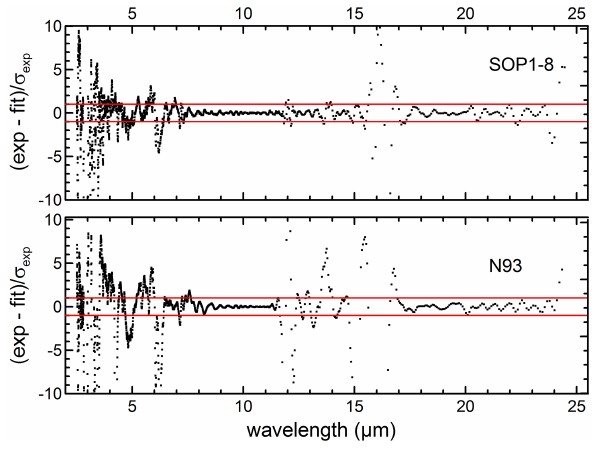
− fit ) ) of the fit normalized by the Figure 5. Residuals ( R = ( exp σ exp measurement errors calculated for SOP1–8 and N93. In the resid- ual calculation, exp is the experimental Q abs (λ)/a , while fit is the Figure 6. Real ( n , top panel) and imaginary ( k , bottom panel) parts Q abs (λ)/a obtained from the fitting procedure. The measurement of the complex refractive index obtained within the range 2.5–25µm error, σ exp , is 6.4% for SOP1–8 and 5.9% for N93. Red lines indi- for the five different dust samples. The legend in the top panel iden- cate the ± 1 interval. tifies the line styles used in the